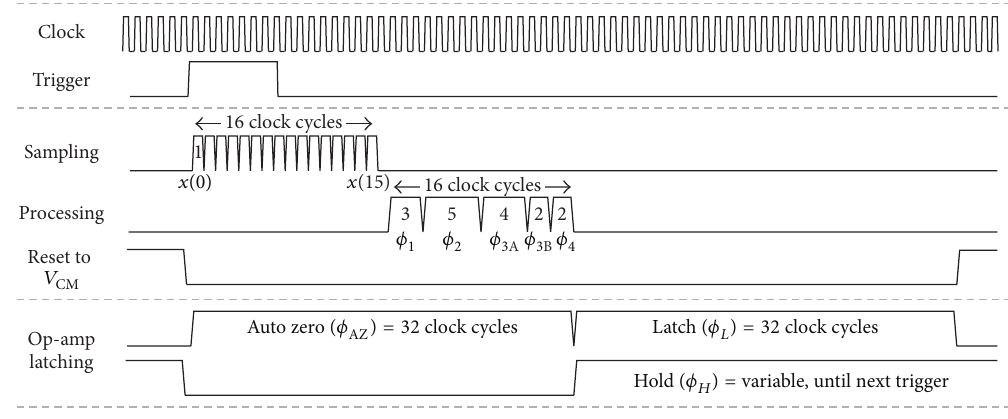
Figure 14: Timing diagram showing the clock, trigger, sampling, processing, reset, and output latch clocks.